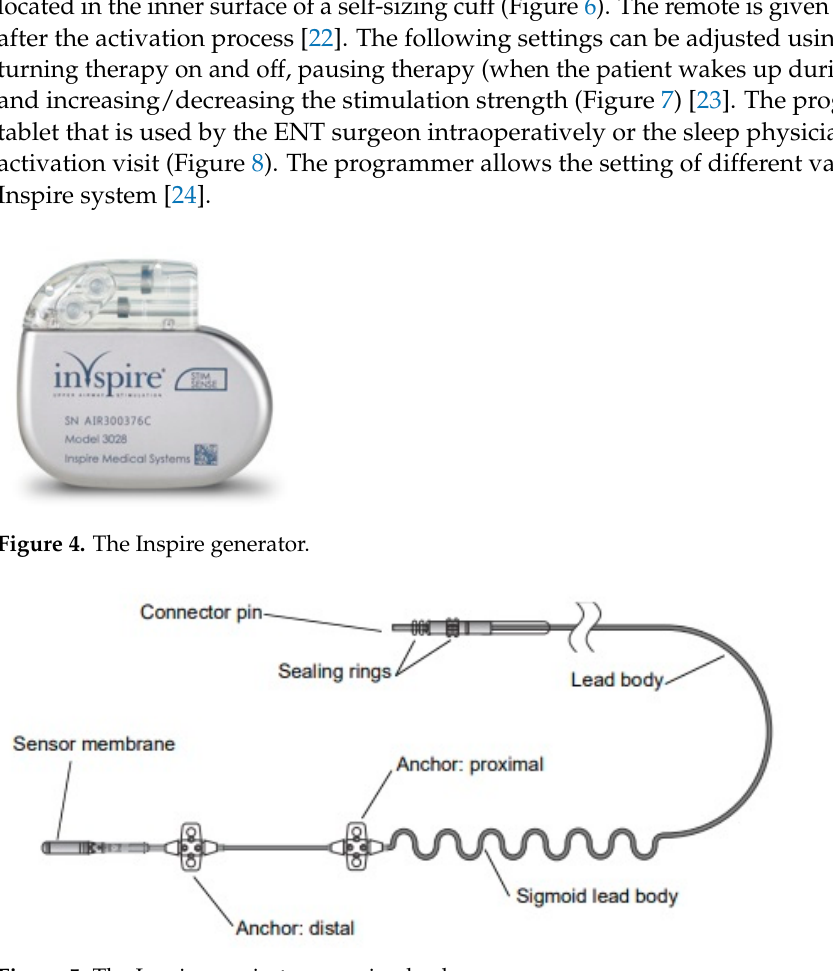
Figure 3. The Inspire system (Maple Grove, MN, USA).